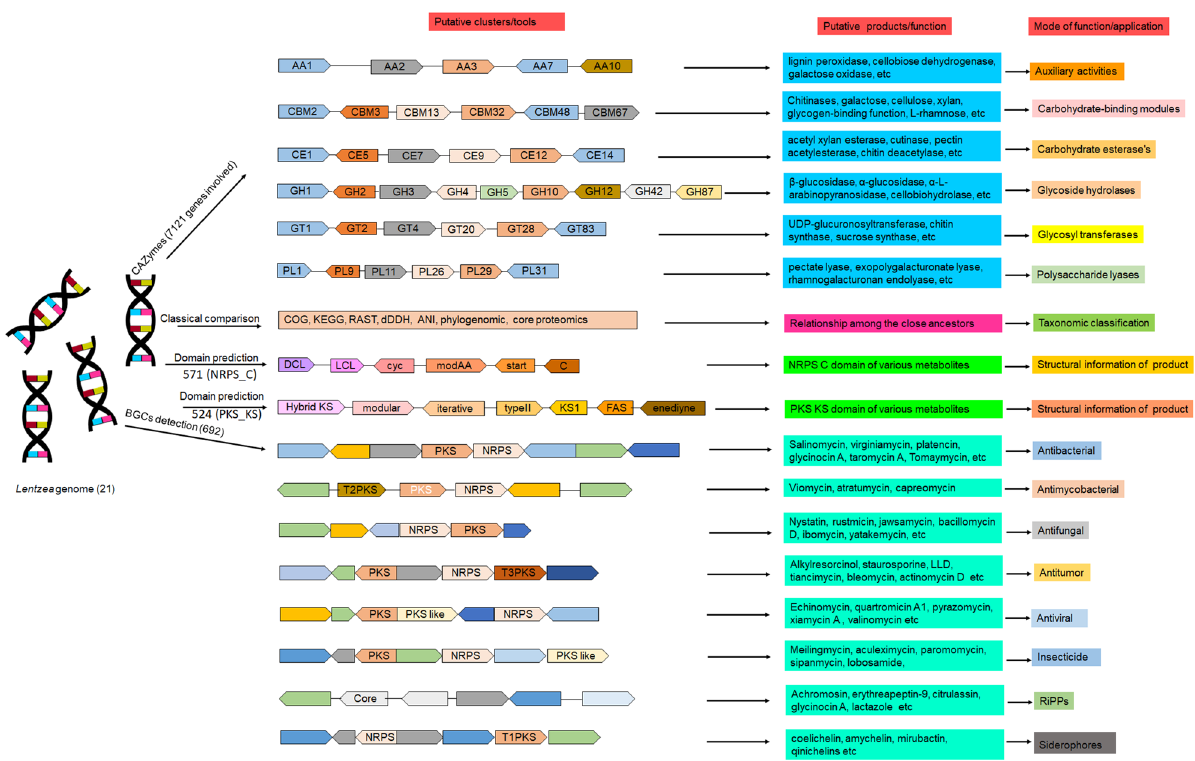
Figure 14. Schematic representation of the summarized work flow for Lentzea genome analysis to demarcate the gene clusters responsible for the production of CAZymes and pharmaceutically relevant secondary